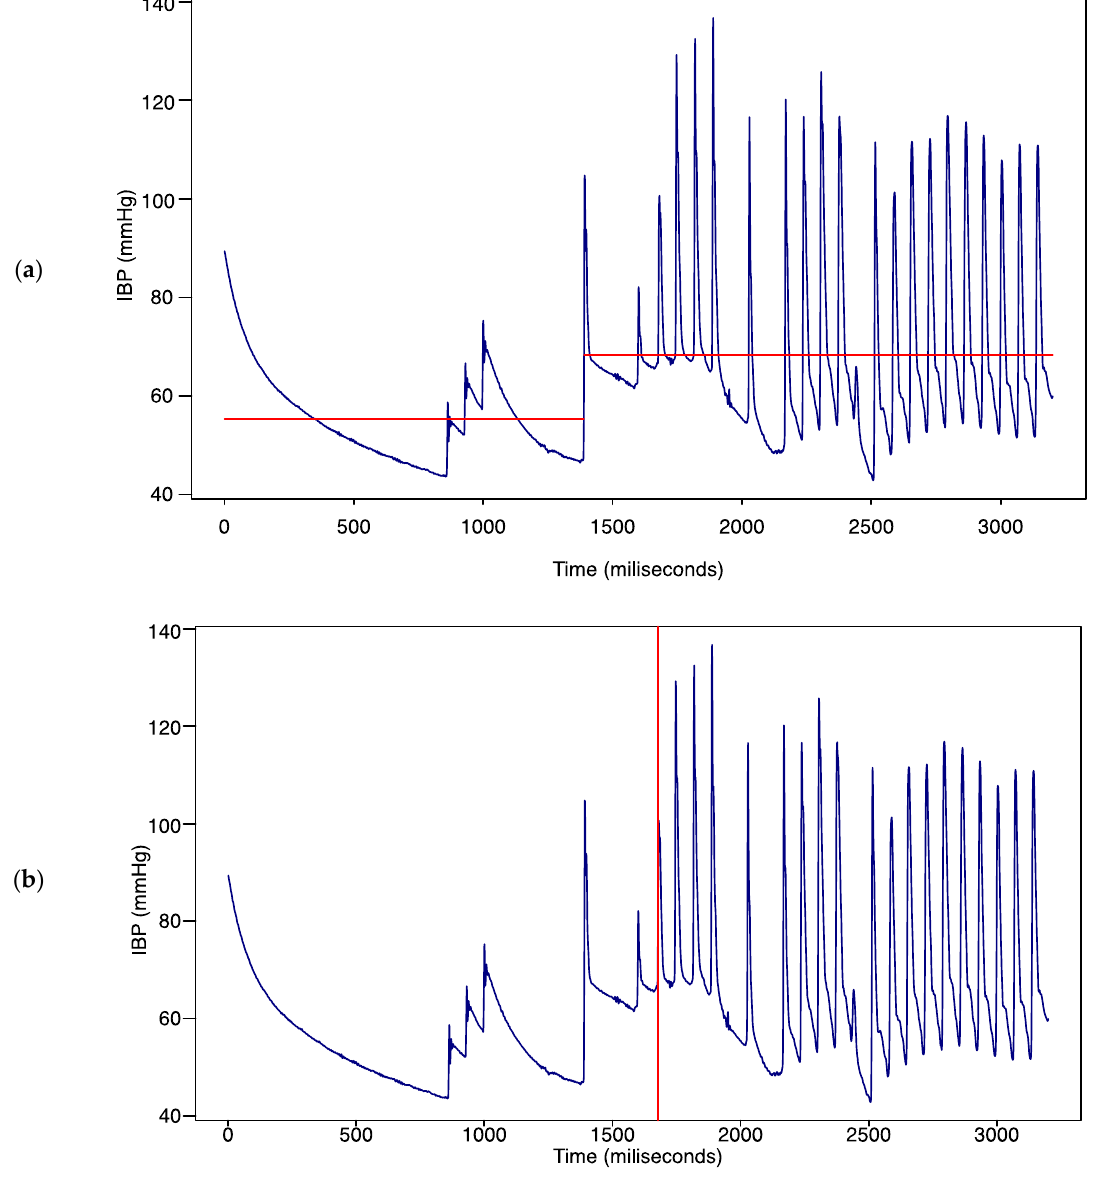
Figure 4. Change points analysis results. ( a ) Mean change; ( b ) variance change.